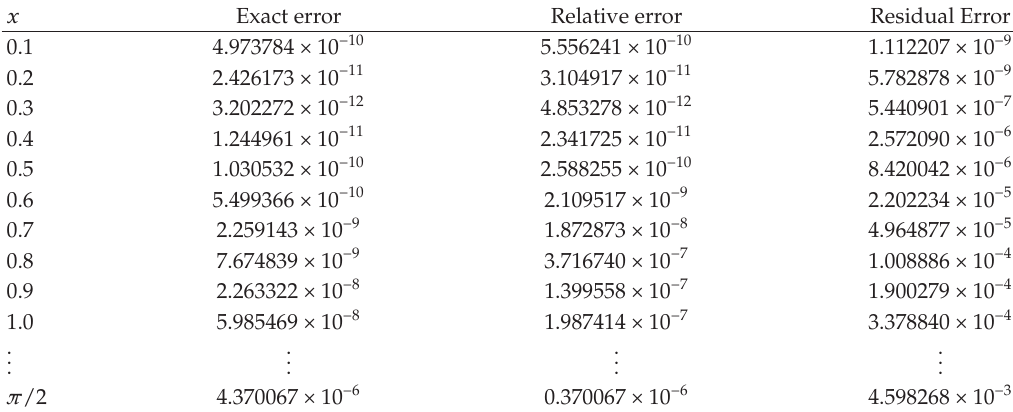
Table 2: Exact, relative, and residual errors of (cid:4) 4.13 (cid:5) and (cid:4) 4.14 (cid:5) at (cid:2) (cid:9) − 1 and κ (cid:9) 1 .